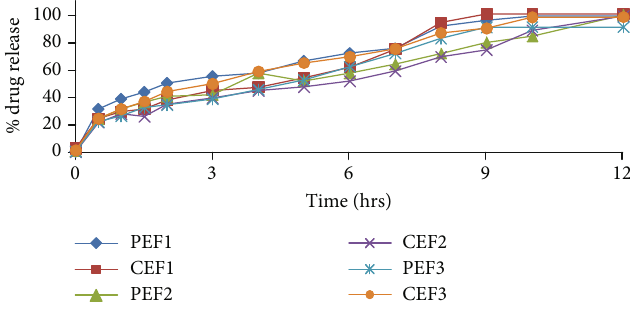
Figure 1: Drug release pro fi le of acetaminophen and ca ff eine at pH 1.2.